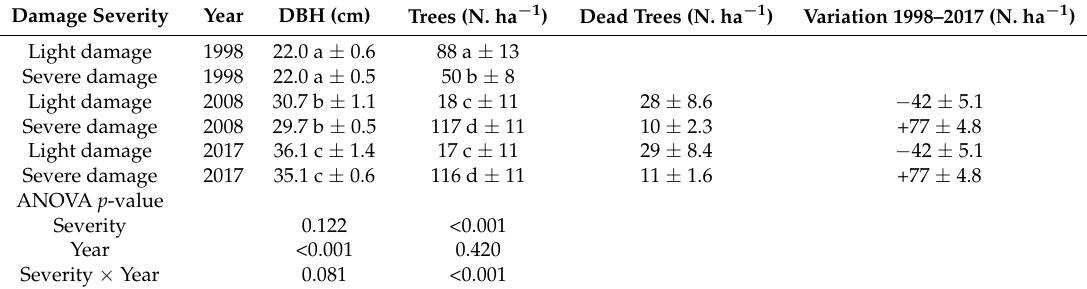
Table 3. Damage severity in trees and diameter at breast height ( ± SD) after thinning in 1998, 2008, and